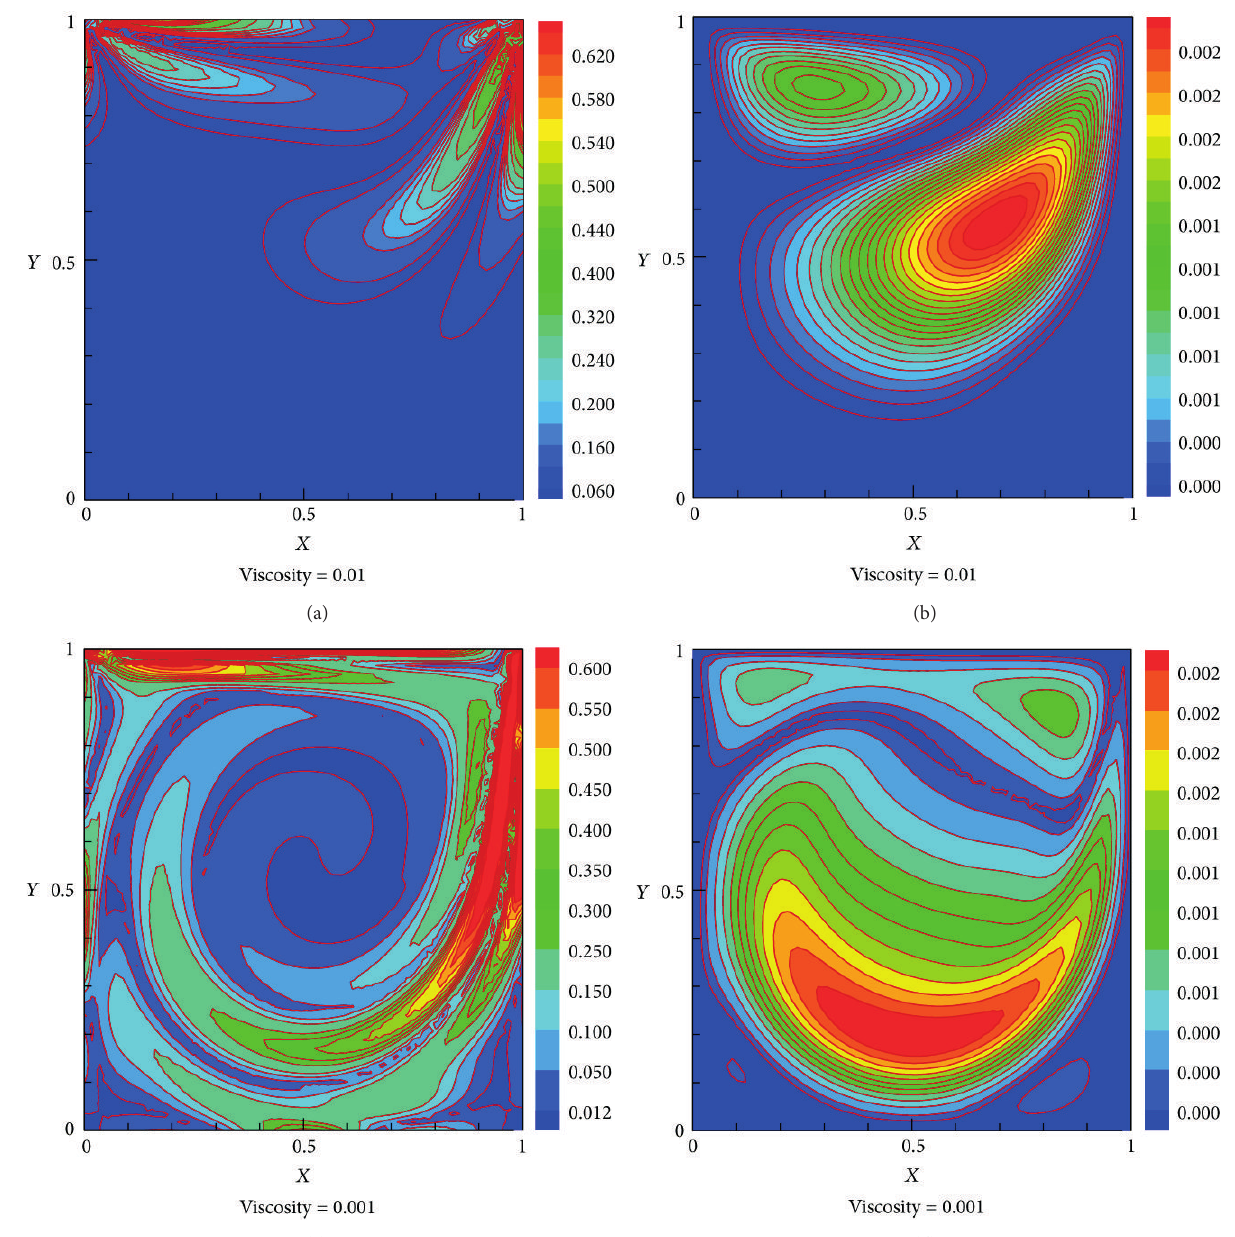
Figure 10: Standard deviation of the vorticity ((a) and (c)) and the stream function ((b) and (d)) for 𝑃 = 2 and 𝑀 = 2 .